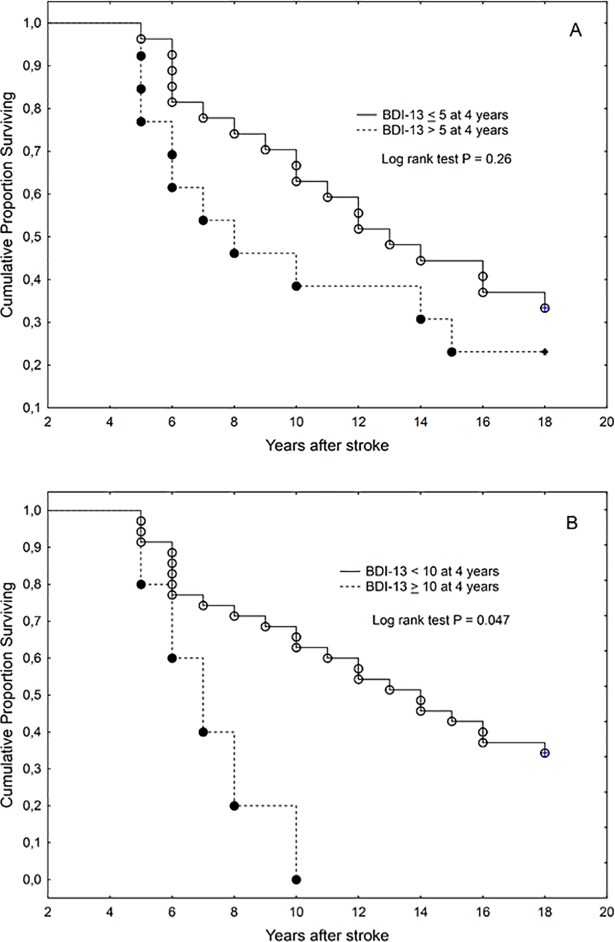
Kaplan-Meier graph of survival in those with Beck Depression Inventory score cutoff values of 5 (A) and 10 (B) at 4 years after stroke (patient subgroup survived at 4 years, n = 41). BDI-13 = Beck Depression Inventory.